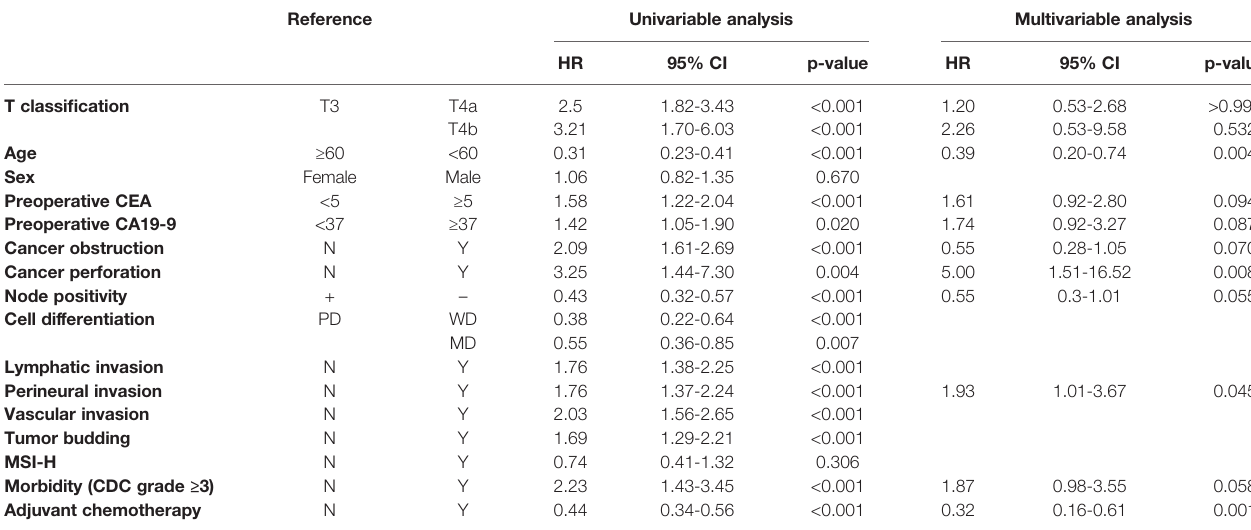
TABLE 3 | Univariable and multivariable cox regression analysis of overall survival.